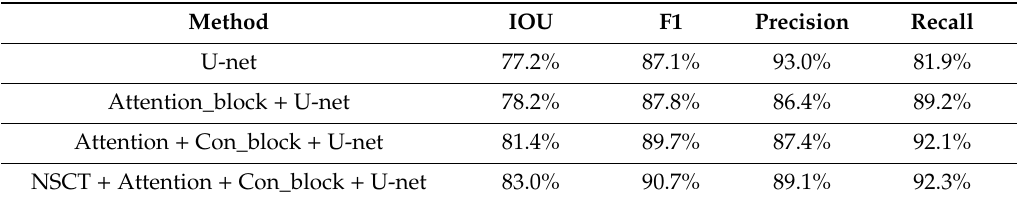
Table 2. Precision, recall, F1-Score (F1), and intersection over union (IOU) scores on the test data of the ablation